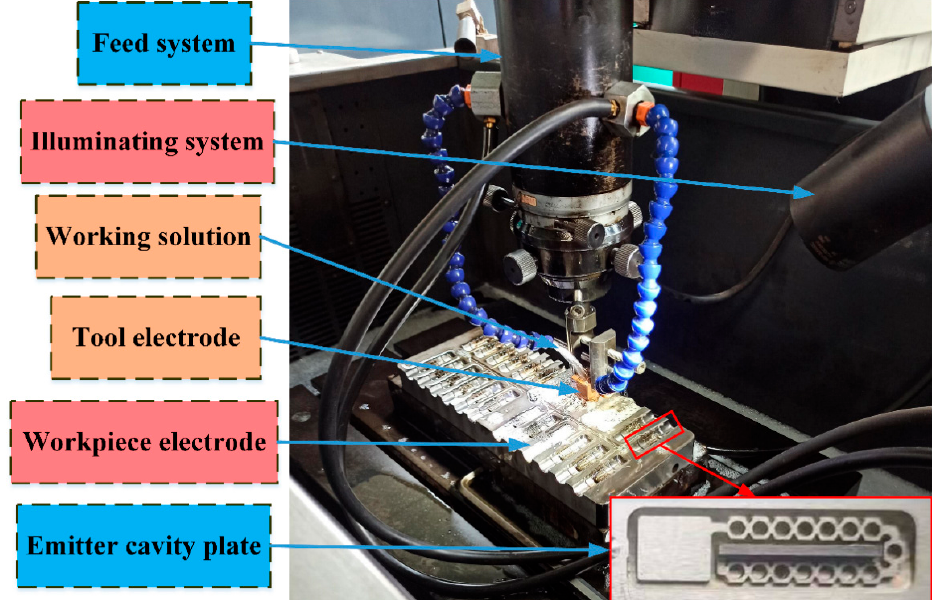
Figure 3. Processing of molds of the novel emitters using EDM.